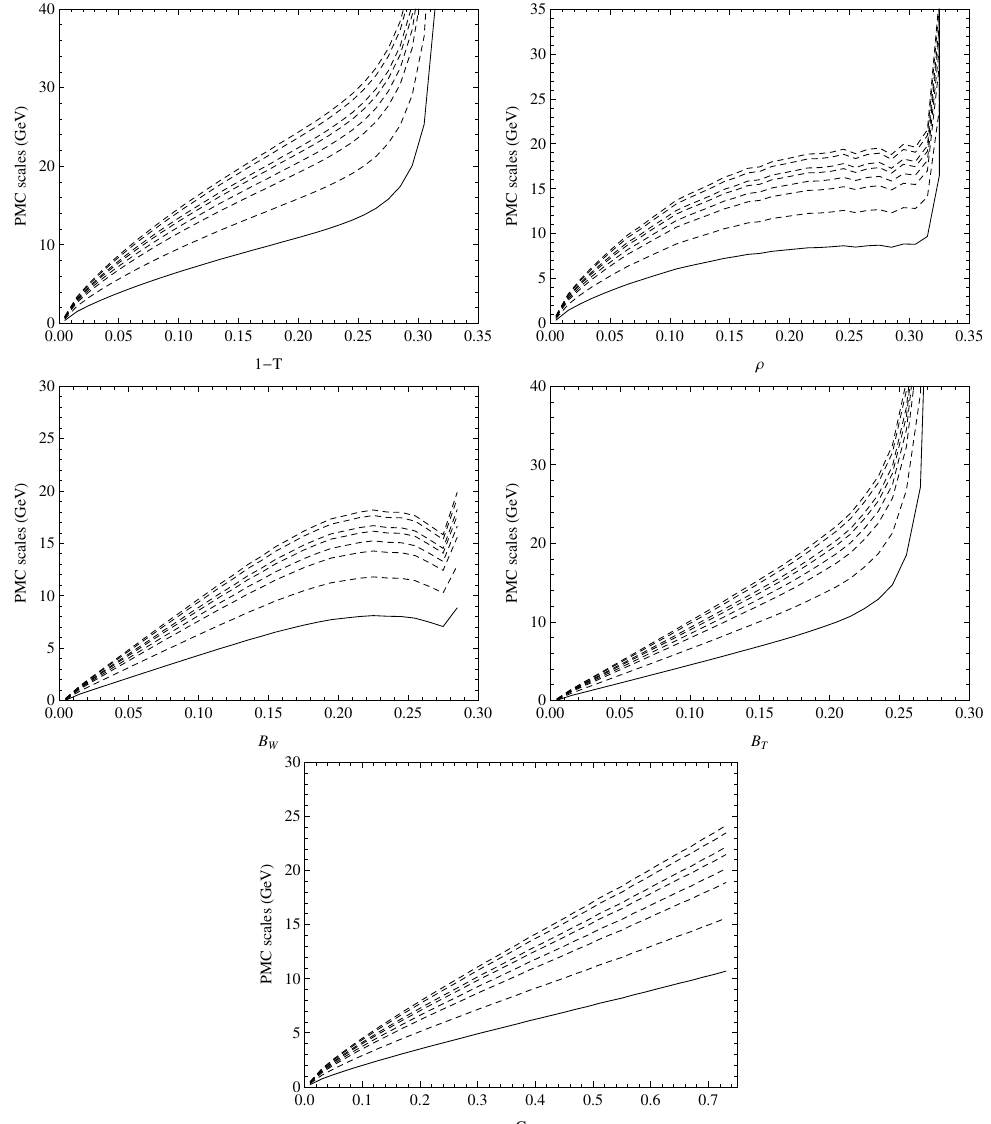
Figure 2. The PMC scales for the event shape observables thrust ( 1 − T ), heavy jet mass ( ρ ), wide jet broadening ( B ), total jet broadening ( B ) and C-parameter ( C ). In each figure, there W T √ are one solid line and seven dashed lines, which represent the PMC scales for s = 91 . 2 GeV and √ s = 133 , 161 , 172 , 183 , 189 , 200 , 206 GeV, respectively. These figures show clearly that the PMC √ scales monotonously increase with the center-of-mass energy s